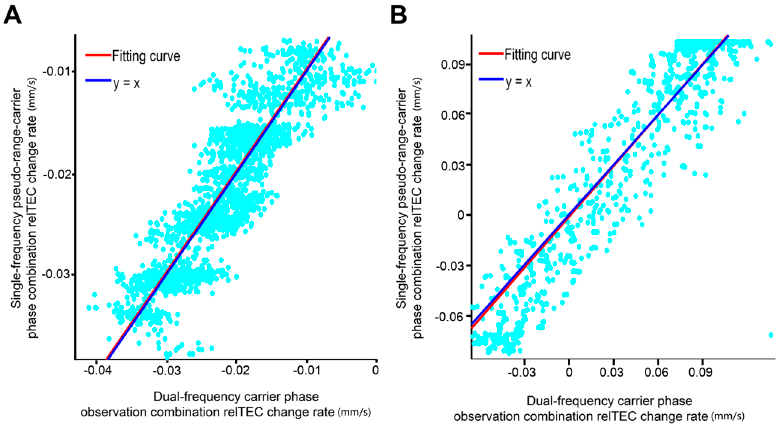
Figure 2. Consistency comparison of the relTEC change rate calculated by single-frequency pseudo-range carrier phase combination and dual-frequency carrier phase combination, ( A ) is occultation event 1 and ( B ) is occultation event